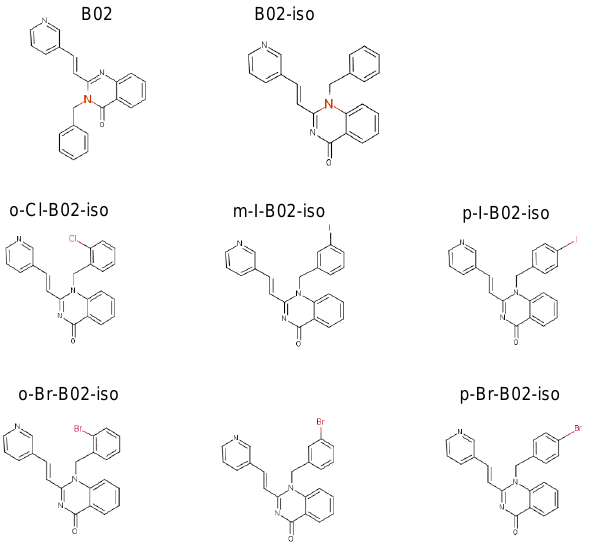
Figure 2. Chemical structures of B02, B02-iso and halogen-containing derivatives of B02-iso.